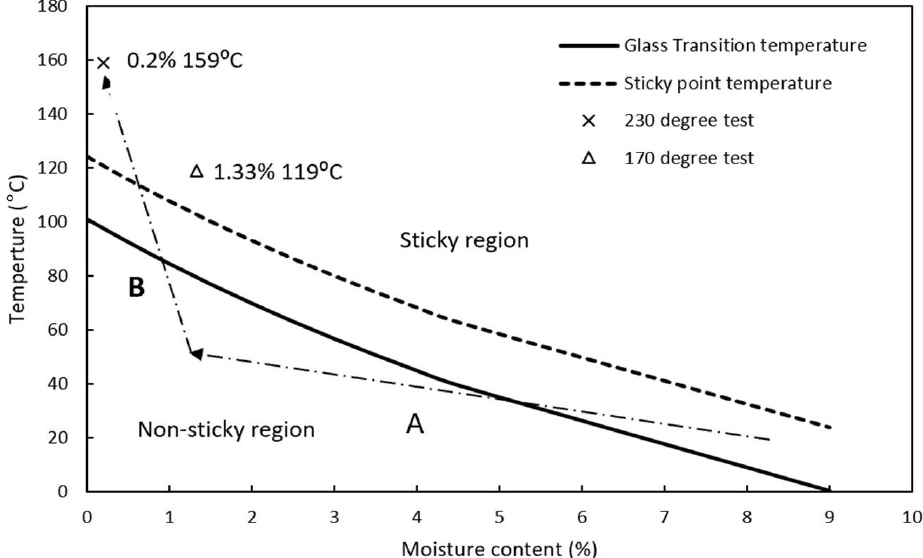
Figure 11. Sticky point schematic diagram of a hypothetical particle undergoing drying from tests at inlet air temperatures of 170 °C and 230 °C [ 41 ] .